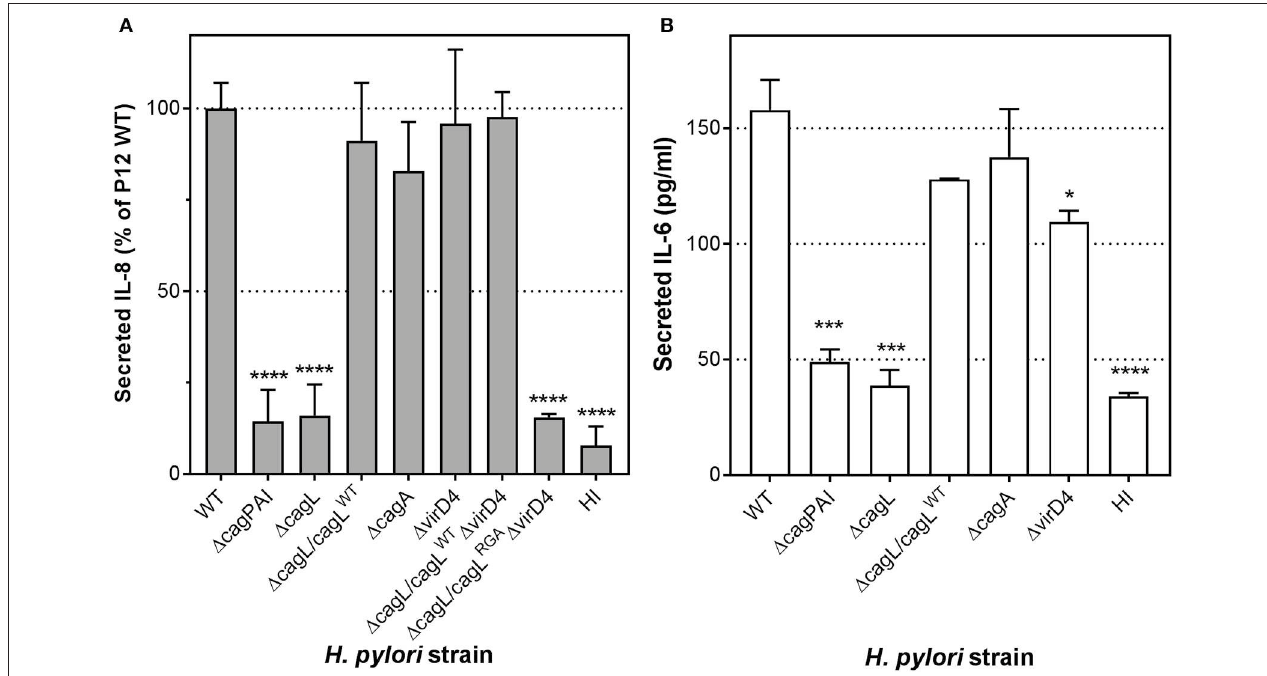
FIGURE 3 | The essential role CagL plays in IL-8 and IL-6 induction in infected human endothelial cells is independent of CagA. (A) Mean secreted IL-8 levels in spent culture medium collected at 24 hpi from HUVECs inoculated with HI, or H. pylori strains P12 WT or various isogenic 1 cagL, 1 cagA, and 1 virD4 single and double mutants at MOI = 10. Error bars denote SEM, N = 4; statistical analysis using two-way ANOVA (Tukey’s multiple comparisons post-test); ****denotes conditions significantly different ( p < 0.0001) to WT. (B) Mean secreted IL-6 levels in spent culture medium collected at 24 hpi from HUVECs inoculated with HI, or H. pylori strains P12 WT or various isogenic 1 cagL, 1 cagA, and 1 virD4 mutants at MOI = 10. Error bars denote SD , N = 2; statistical analysis using two-way ANOVA (Tukey’s multiple comparisons post-test); *, ***, and **** denote conditions significantly different ( p < 0.05, p < 0.001, and p < 0.0001, respectively) to WT.